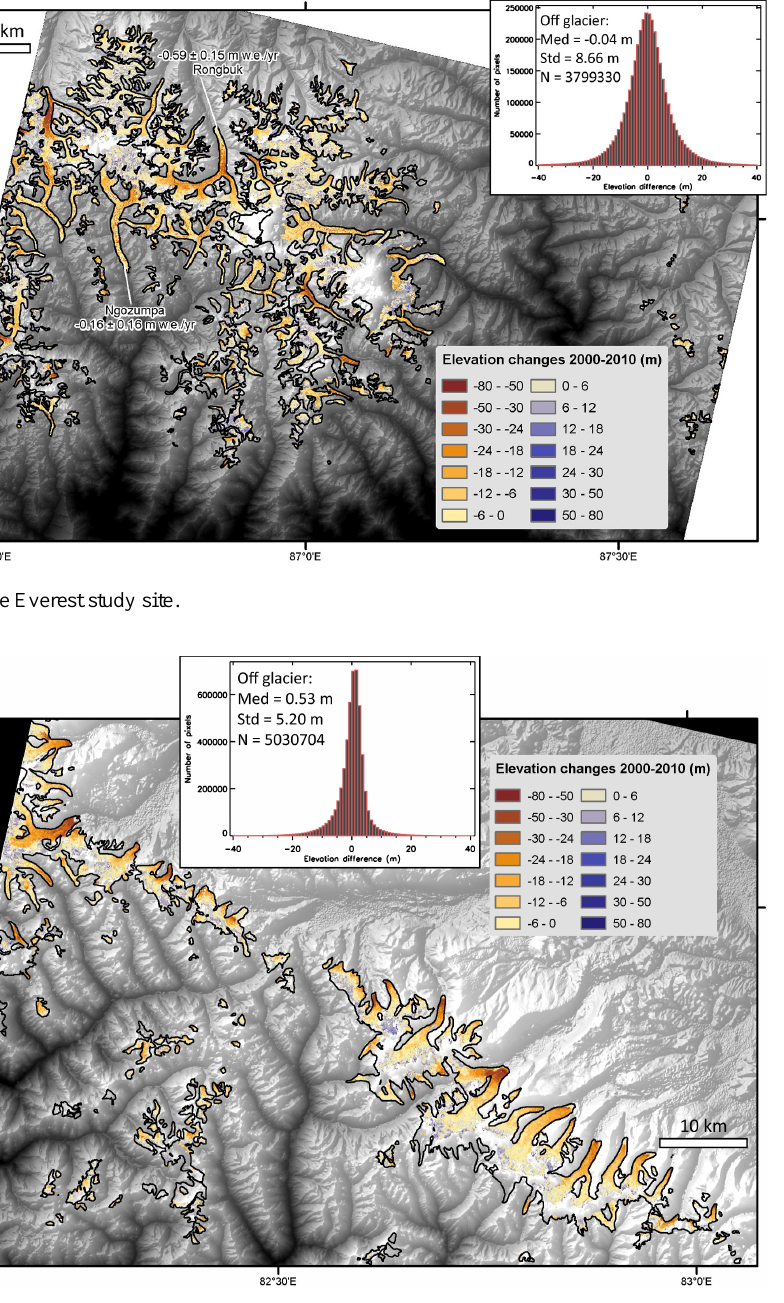
Fig. 5. Same as Fig. 2 but for the West Nepal study